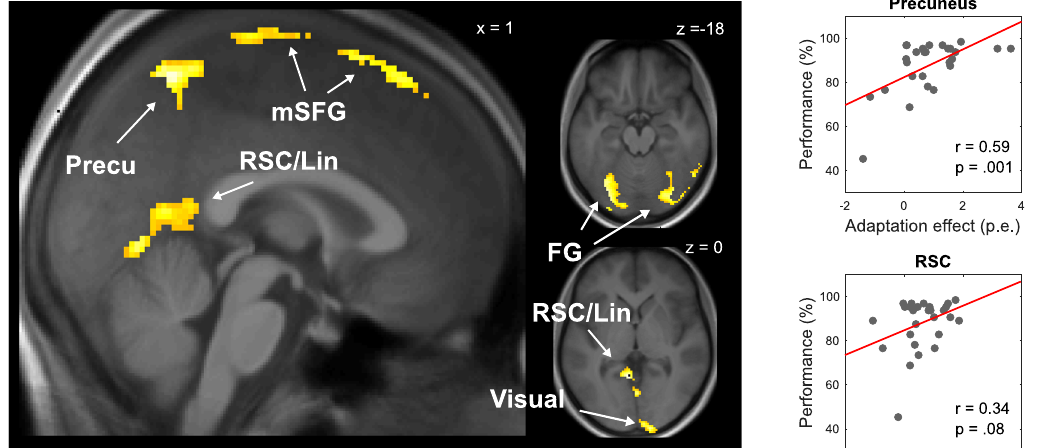
represent heading direction during spatial navigation, such as the entorhinal and parahippocampal cortices, the subiculum, and the thalamus, that were not revealed by our whole-brain approach (e.g., refs. 12,14 – 18,25 ). Moreover, extrastriate regions in Brod- mann ’ s area 19 (V5/MT) are known to represent motion direc- tion of visual stimuli 26,27 . Therefore, we used an ROI-based approach (see ‘ Methods ’ ) to search for fMRI adaptation to direction in all these additional regions. The results indicated that among them only the thalamus and BA19 showed absolute direction adaptation (thalamus: mean parameter estimate (p.e.) = − 0.19 (std = 0.29), p = 0.002; entorhinal cortex: mean p.e. = 0.07 (std = 0.36), p = 0.15; parahippocampal cortex: mean p.e. = − 0.10 (std = 0.30), p = 0.10; subiculum: mean p.e. = 0.045 (std = 0.52), p = 0.65; BA19: mean p.e. = 0.18, std = 0.39,